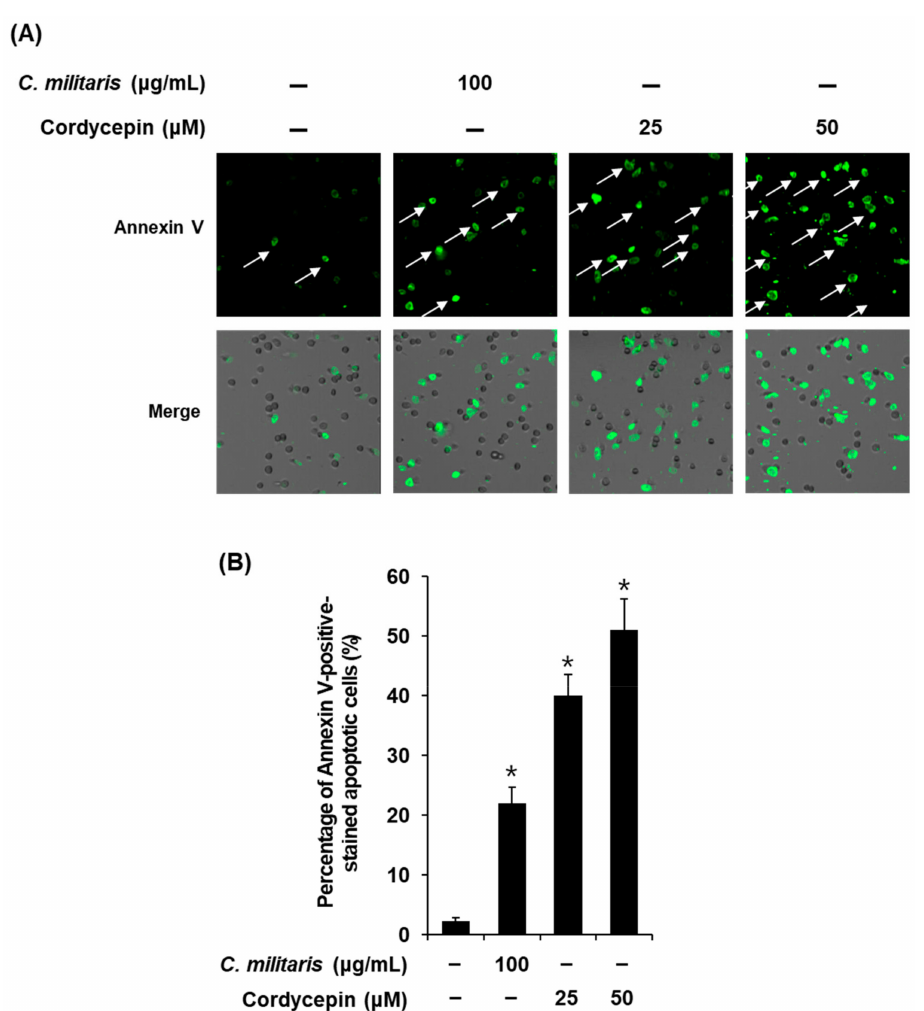
Figure 3. E ff ects of Cordyceps militaris concentrate (100 µ g / mL) and cordycepin (25 and 50 µ M) on apoptosis in MCF-7 breast cancer cells exposed for 24 h by image-based cytometric assay. ( A ) Representative images for apoptosis detection; ( B ) Percentage of Annexin V-positive-stained apoptotic cells. Data are the means of experiments performed in triplicate. Data are presented as the mean ± SD. and were analyzed using the Student’s t -test. * p < 0.05 versus non treated